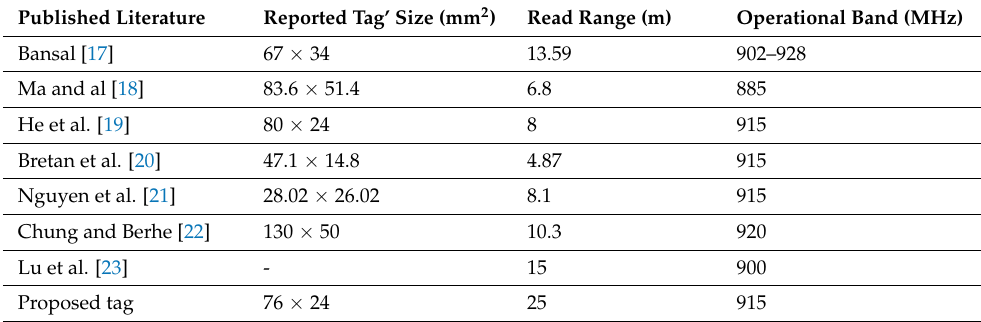
Figure 18. Radiation of proposed RFID antenna. ( a ) At 837 MHz. ( b ) At 927 MHz. Table 1. The performances of the antennas proposed in the literature vs. the performance of the proposed M730 chip with − 24 dB sensitivity [16], and an omnidirectional radiation pattern at both